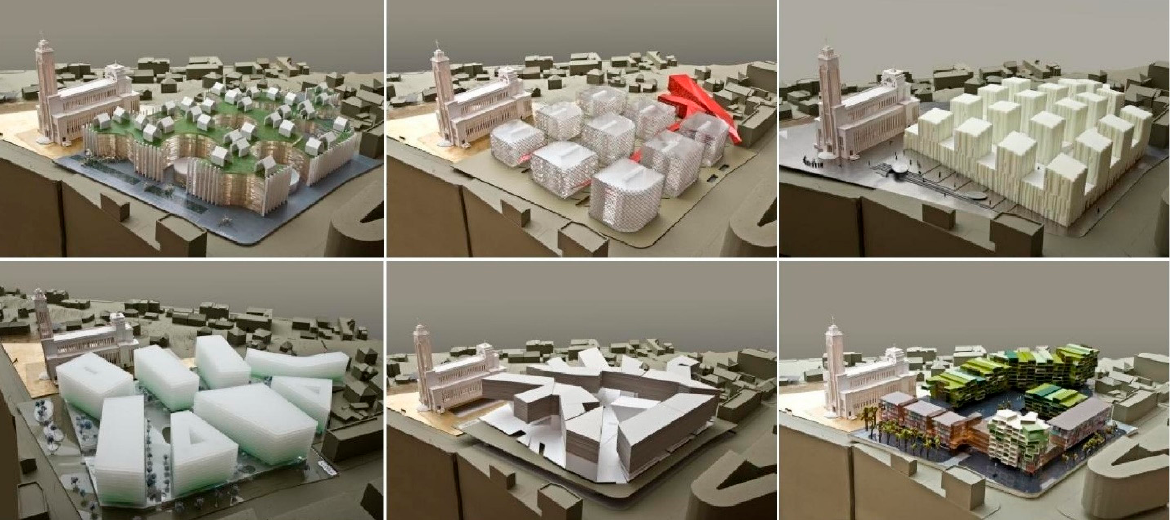
Figure 17. The project proposals for the conversion, 2008 (source: Architects’ Association of Lithua- nia).